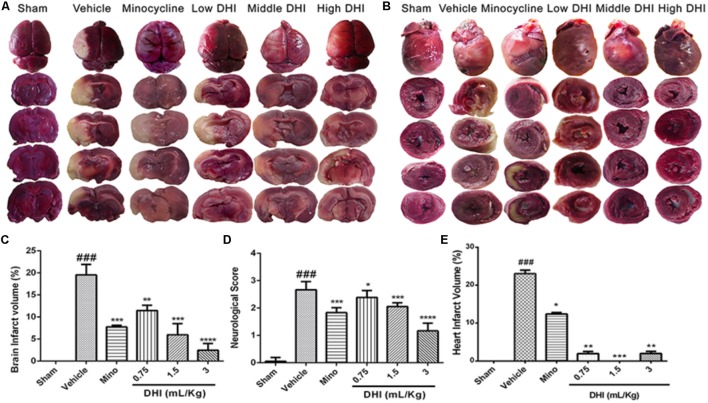
Danhong injection (DHI) attenuates brain infarct and neurological deficits at the early time point of reperfusion (n = 5 in each group). (A) Whole brain and brain slices stained with TTC 48 h after CI/RI. (B) Transverse sections of the hearts from the same animals stained with TTC 48 h post-reperfusion. Infarct was significantly detected in the vehicle (###p < 0.001 vs. sham) but decreased in the treatment groups (∗p < 0.05, ∗∗p < 0.01, and ∗∗∗p < 0.001 vs. vehicle; B,E). (C) MCAO procedure caused a marked increase in infarct volume (###p < 0.001 vs. sham) but decreased significantly in drug groups (∗∗p < 0.01, ∗∗∗p < 0.001, and ∗∗∗∗p < 0.0001 vs. vehicle). (D) Neurological deficit scores decreased statistically in drug-treated groups (∗p < 0.05, ∗∗∗p < 0.001, and ∗∗∗∗p < 0.0001 vs. vehicle) but remained high in the vehicle group (###p < 0.001 vs. sham).